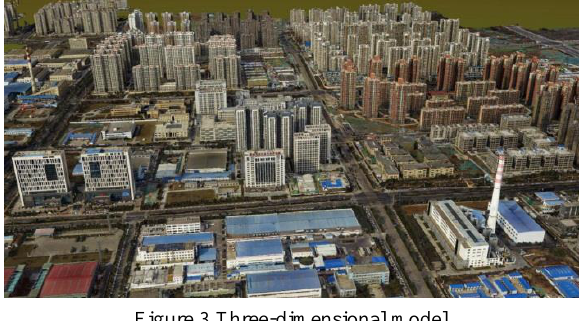
Figure 3.Three-dimensional model